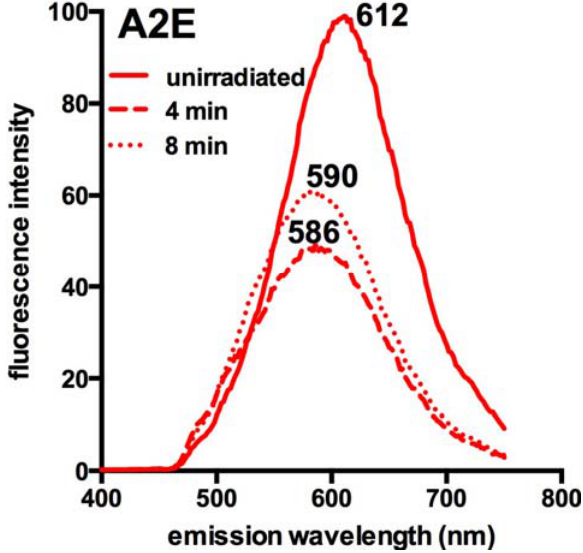
Figure 4. A2E photobleaching by irradiation at 480 nm for 4 and 8 min. Fluorescence intensity decreases with irradiation and the emission maximum undergoes a hypsochromic shift. Emission peak wavelengths (nm) are indicated adjacent to each trace.